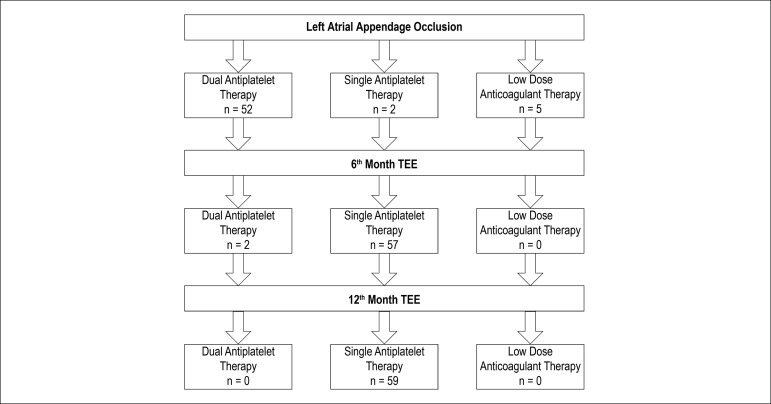
Postprocedural antithrombotic treatment.